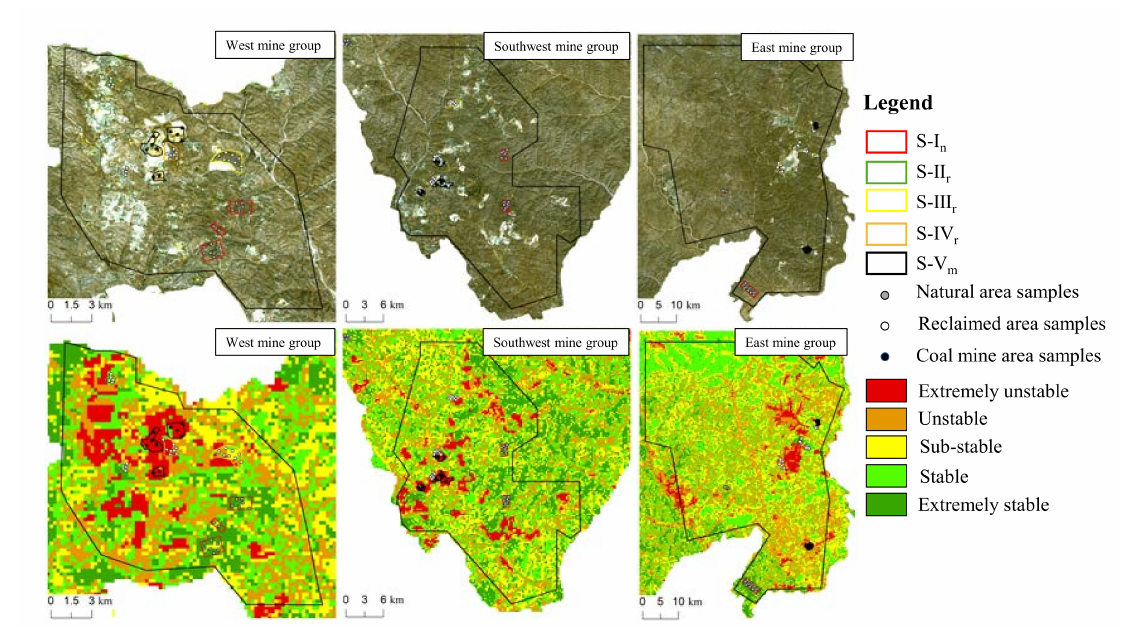
Figure 3. Schematic illustration of sampling points in each coal mining area based on ecological stability in 2017.